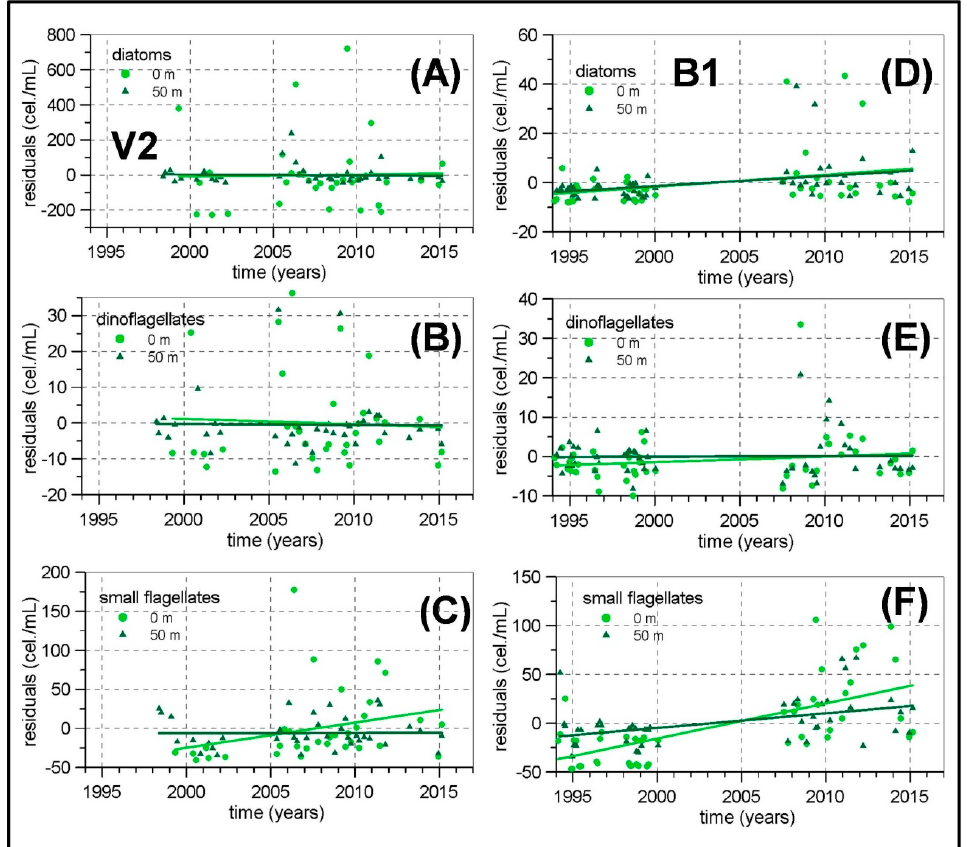
Figure 9. Time series of residuals of the micro-phytoplanktonic time series at stations V2 and B1. ( A – C ) correspond to diatoms, dinoflagellates and small flagellates at station V2. ( D – F ) correspond to diatoms, dinoflagellates and small flagellates at station B1. In all the figures light green dots are used for the time series of residuals at 0 m depth, and the dark green dots are used for the time series of residuals at 50 m depth. Solid lines are the straight lines fitted by means of least squares fit to each time series.